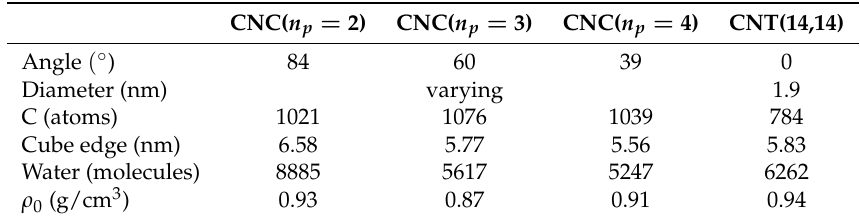
Table 2. Properties of the carbon nanocones (CNCs) and carbon nanotubes (CNTs), the size of the simulation cubes and the initial solvation (water) densities, ρ 0